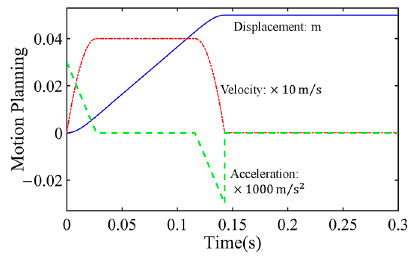
Figure 9. Motion planning of a cubic curve.